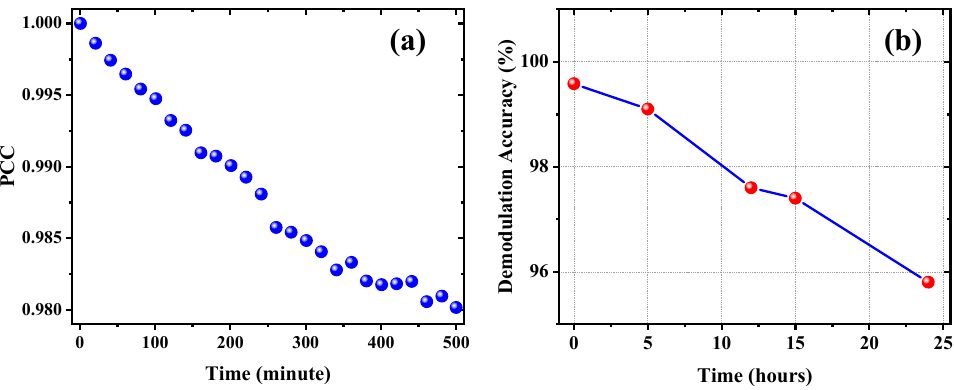
Figure 7. Long-term quantification of the accuracy of the sensing system: ( a ) stability test results of the sensing system; ( b ) time decay of sensing calibration accuracy.